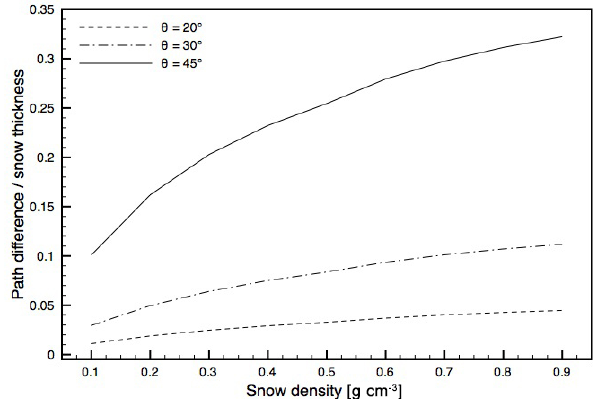
Figure 7. Normalized path difference (cid:49)s/h as a function of snow density ρ ds . For explanations, see